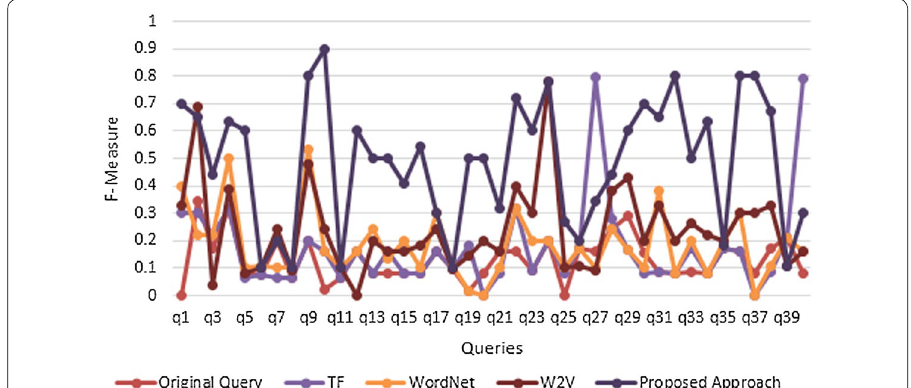
Fig. 2 F‑measure values of top ten retrieved documents with respect to 40